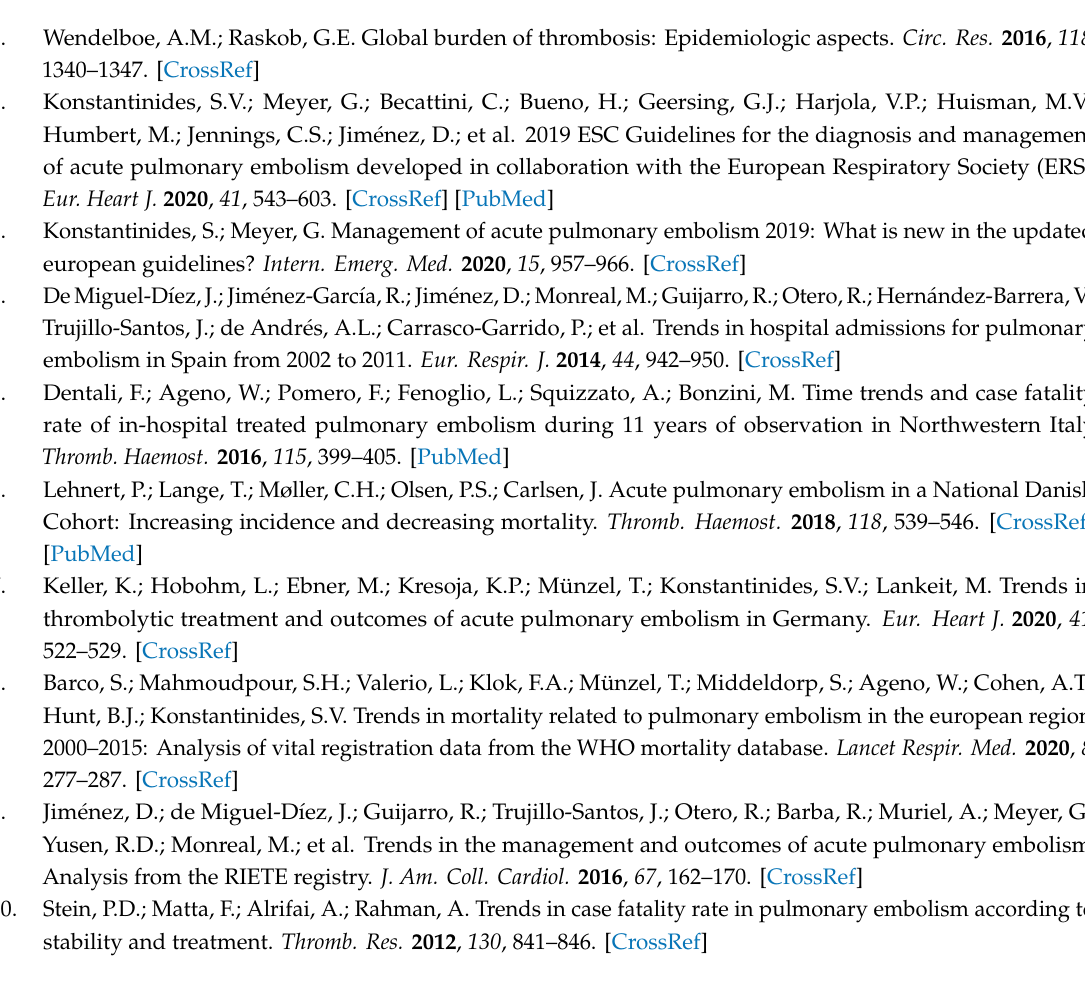
Table S1: ICD-9-CM codes and ICD-10 codes used to define pulmonary embolism for study purpose based on Smith et al., Table S2: ICD-9-CM and ICD-10 codes for the clinical diagnosis and procedures used in this investigation, Table S3: Sensitivity analysis including acute cor pulmonale (ACP) in the definition of pulmonary embolism (PE). Number of cases, proportions, incidences rates, and in-hospital mortality (IHM) according to sex. Author Contributions: Conceptualization, J.d.M.-D. and R.J.-G.; Data curation, V.H.-B. and D.C.-A.;